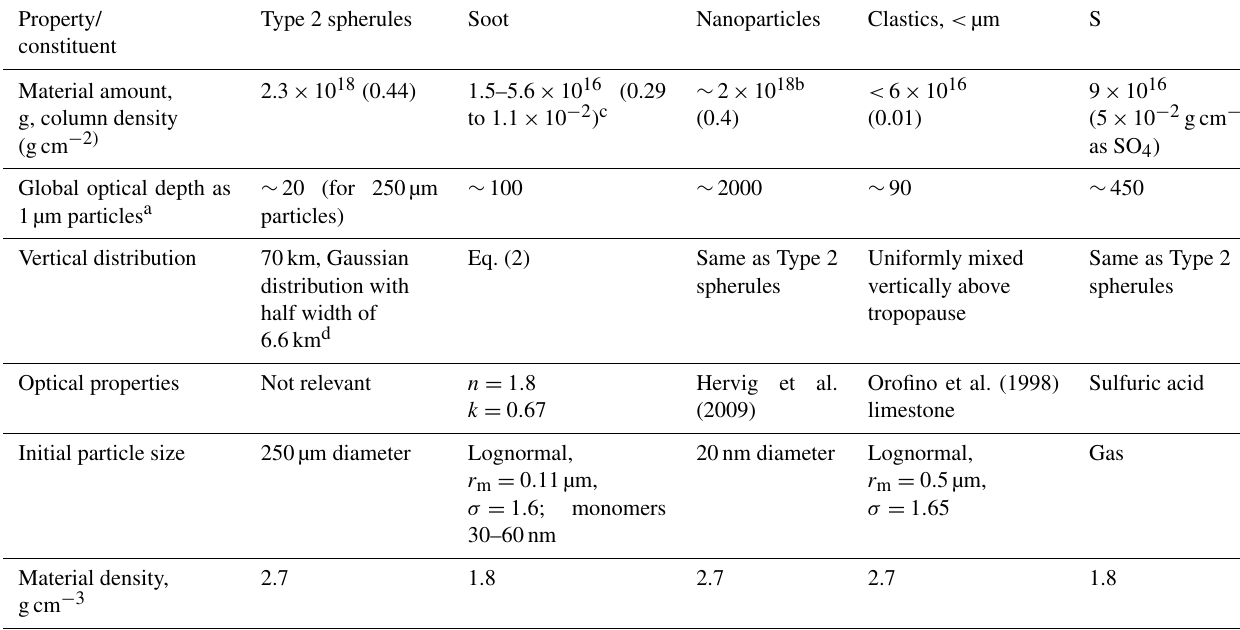
Table 1. K-Pg injection scenario for impactor mass ∼ 1.4 × 10 18 g; impact energy ∼ 2.8 × 10 23 J = 6.8 × 10 7 Mt for 20kms − 1